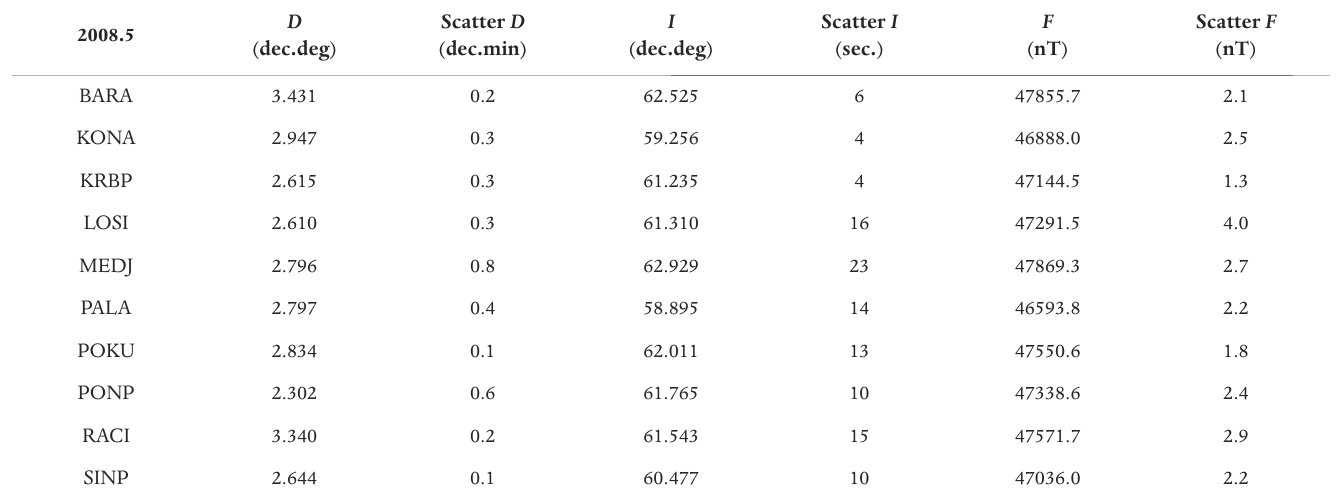
Table 2. CGRSN data reduced to epoch